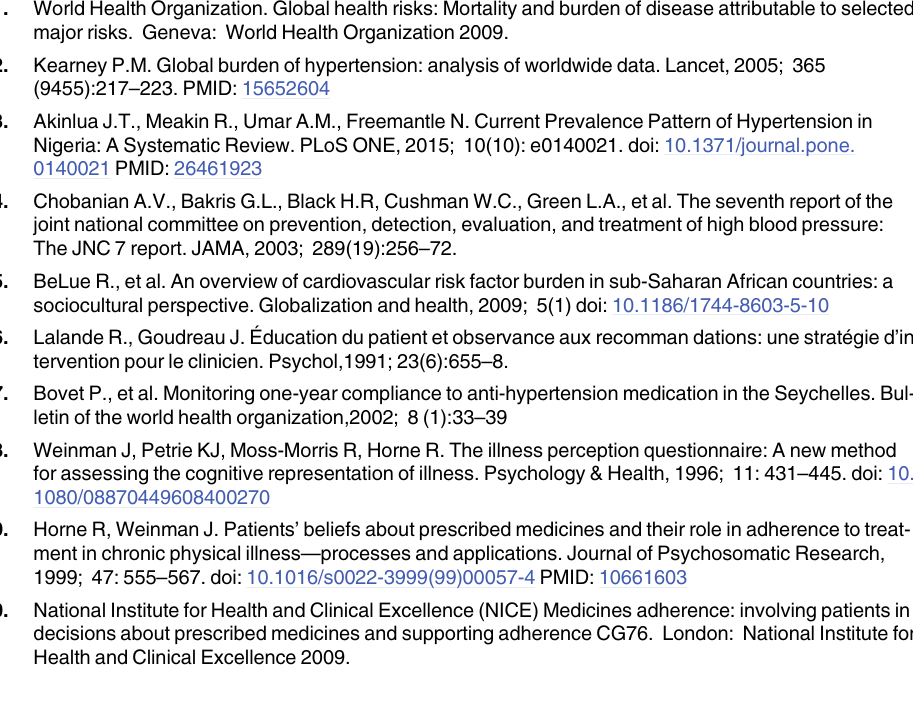
S4 Table. Detailed study characteristics of Mixed Methods Studies. S5 Table. Detailed study characteristics of quantitative Studies. S6 Table. Quality appraisal of qualitative studies. S7 Table. Quality appraisal of mixed methods studies using MMAT (adapted from MMAT-Version 2011) see original tool from MMAT website below.